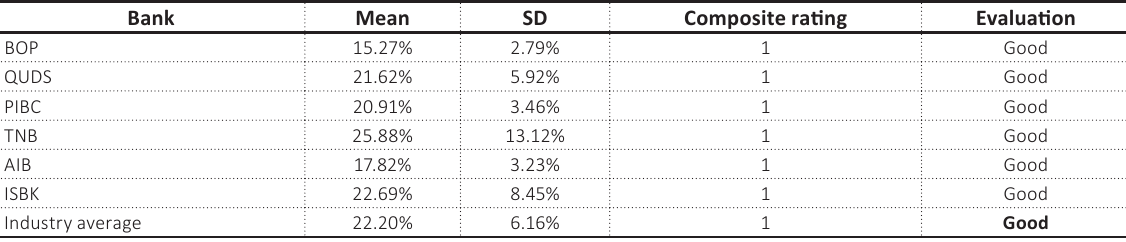
Table 5. Average capital adequacy ratio (2007–2017)